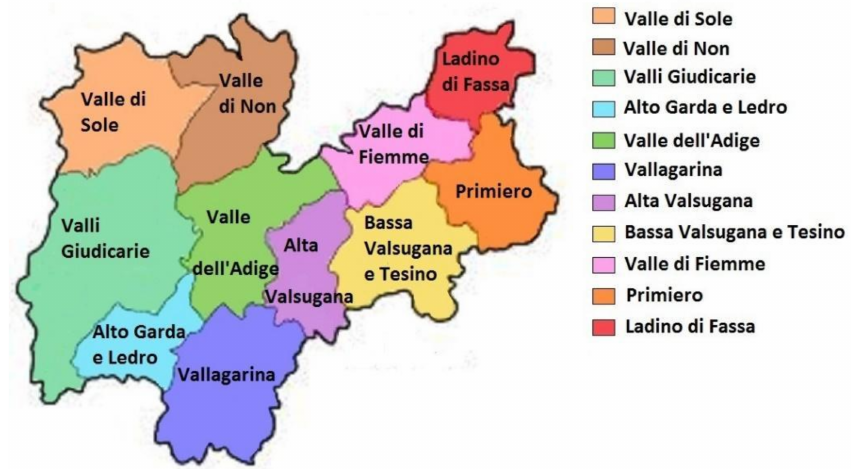
Figure 1. Map of the study area. Image adapted from Provincia Autonoma di Trento (https://www. provincia.tn.it/, accessed on 11 July 2022).